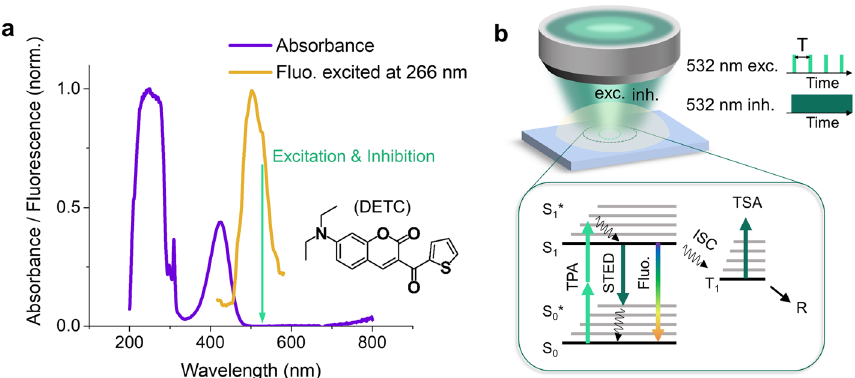
fluorescence (yellow) spectra of the photoinitiator DETC dissolved in the monomers. b Energy level scheme and transitions in a photoinitiator molecule under both excitation and inhibition illumination. Time sequences of a pulsed laser and a CW laser are shown for excitation and inhibition in SC-PPI lithography, where T is the femtosecond pulse repetition time. TPA, two-photon absorption; STED, stimulated emission depletion; ISC, intersystem crossing; TSA, triplet state absorption; R,